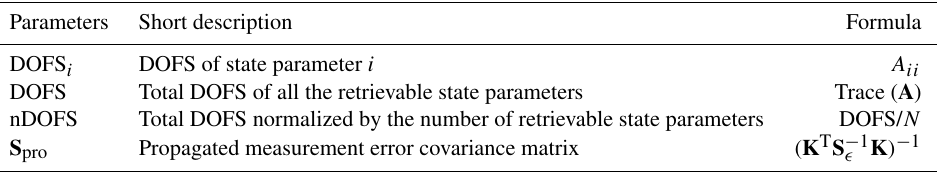
Table 1. Summary of the information content metrics used in this